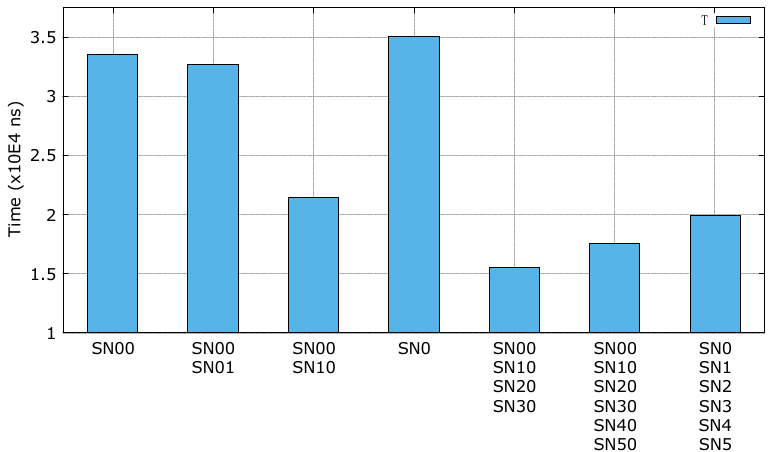
Figure 9. Time comparison of different moving modes. The “SN00” represents the core 0 of the supernode 0 (SN0), and “SN0” represents the four cores in the supernode. The other markers are